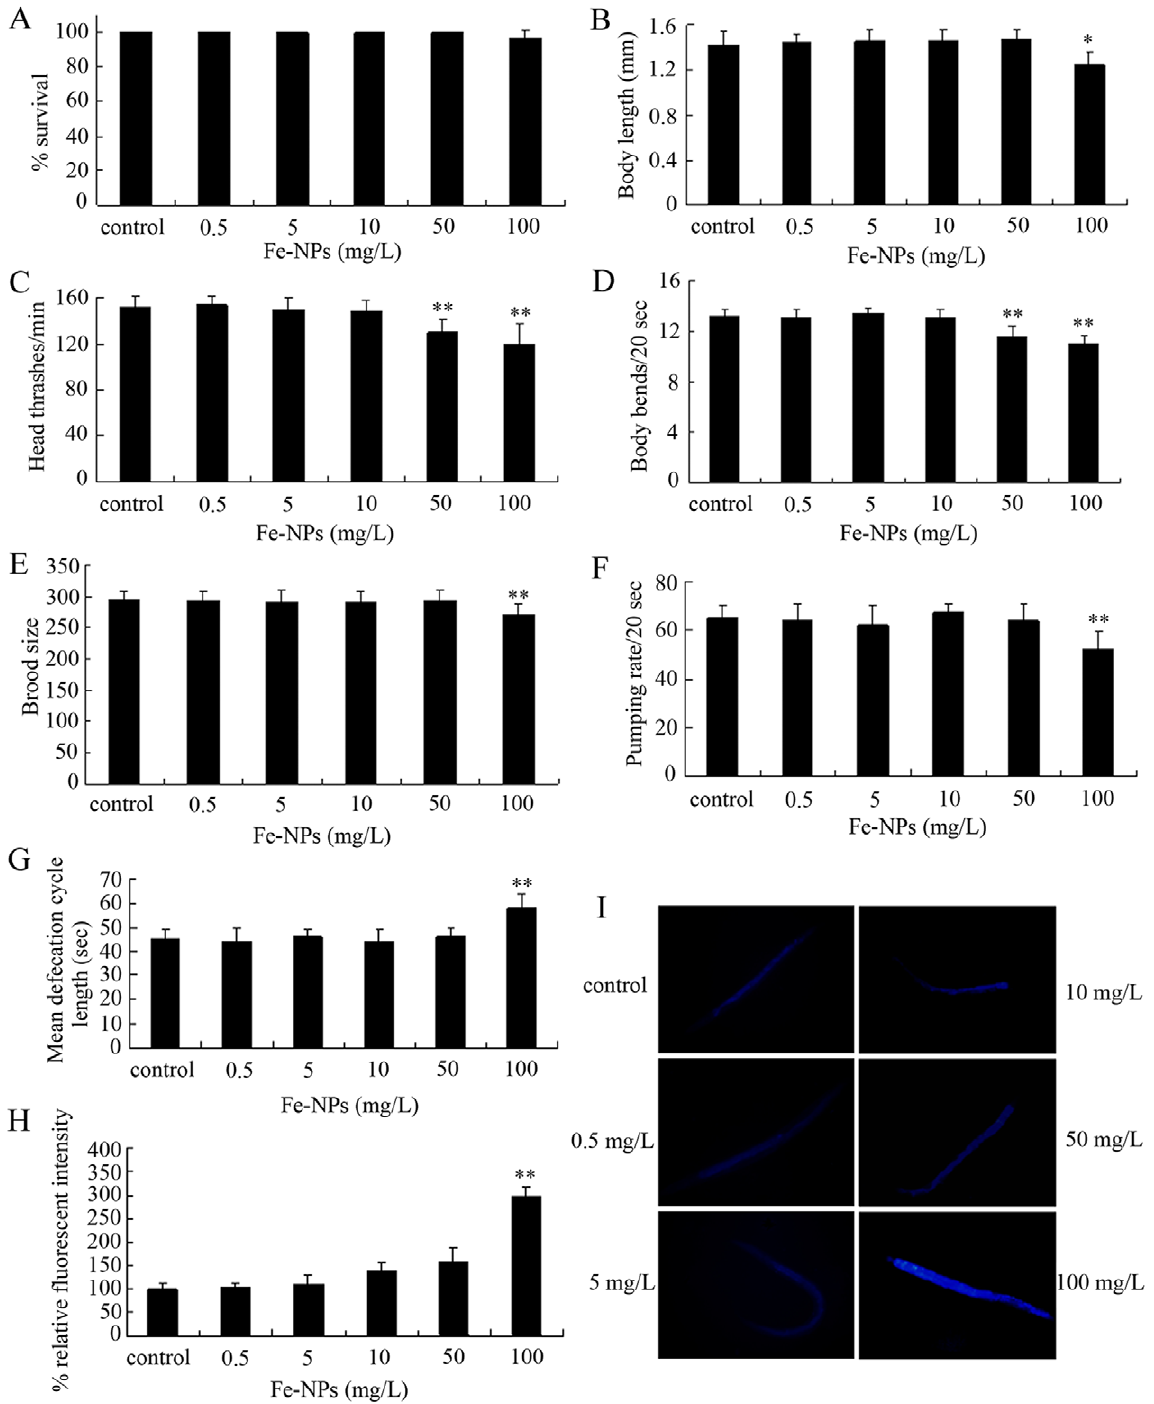
Figure 1. Toxicity evaluation in nematodes exposed to DMSA coated Fe 2 O 3 -nanoparticles at the L4-larvae stage for 24-hr. (A) Comparison of lethality in nematodes exposed to different concentrations of Fe 2 O 3 -nanoparticles. (B) Comparison of body length in nematodes exposed to different concentrations of Fe 2 O 3 -nanoparticles. (C) Comparison of head thrash in nematodes exposed to different concentrations of Fe 2 O 3 -nanoparticles. (D) Comparison of body bend in nematodes exposed to different concentrations of Fe 2 O 3 -nanoparticles. (E) Comparison of brood size in nematodes exposed to different concentrations of Fe 2 O 3 -nanoparticles. (F) Comparison of pumping rate in nematodes exposed to different concentrations of Fe 2 O 3 -nanoparticles. (G) Comparison of mean defecation cycle length in nematodes exposed to different concentrations of Fe 2 O 3 -nanoparticles. (H) Comparison of intestinal autofluorescence in nematodes exposed to different concentrations of Fe 2 O 3 -nanoparticles. (I) Pictures showing the intestinal autofluorescence in nematodes exposed to different concentrations of Fe 2 O 3 -nanoparticles. Bars represent mean 6 S.E.M. * p , 0.05, ** p , 0.01.